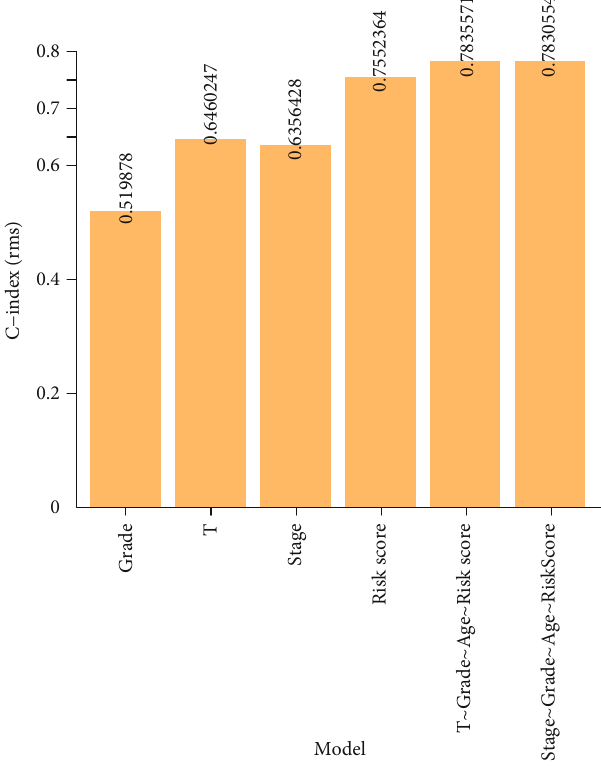
Figure 6: Comparison of C-index among multivariate prognostic modules, risk score, and clinical feature (T, stage, and